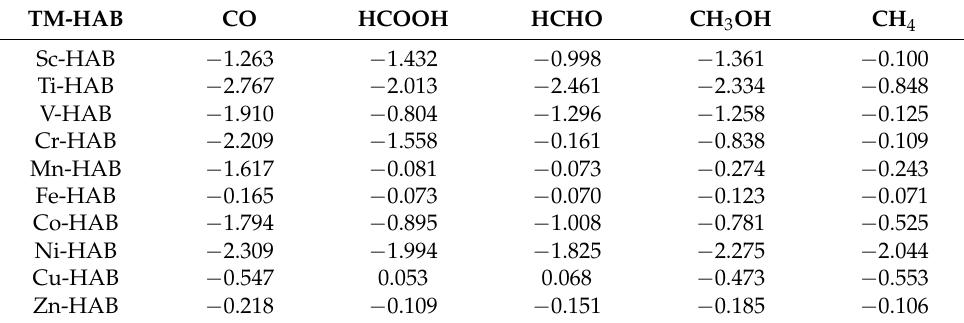
Table 2. Adsorption energy (Eads/eV) of different CO 2 reduction